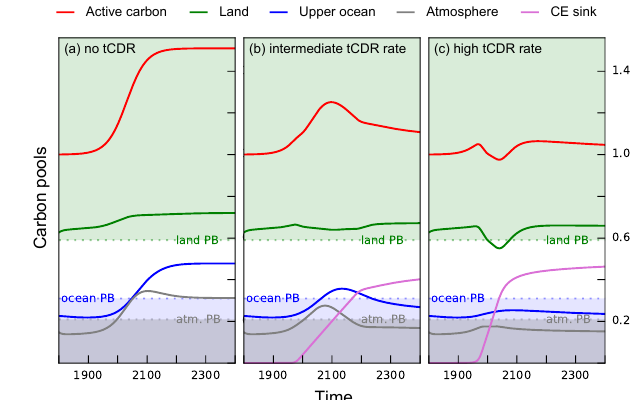
Figure 5. Time evolution of the normalised carbon pools in our model of the carbon system for three tCDR configurations with a high-emission baseline (cumulative emissions as in RCP8.5; Riahi et al., 2011) (a) without tCDR ( α max = 0), (b) intermediate tCDR rate ( α max = 0 . 0025) and (c) high tCDR rate ( α max = 0 . 025). To- tal active carbon (red) is increased by fossil fuel emissions ( c max = 0 . 51) with dynamic response of the terrestrial carbon pool (green), maritime carbon pool (blue) and atmospheric carbon pool (grey). The tCDR sink (purple) stores carbon extracted from the active system. Shaded areas represent the respective safe regions of land, ocean and atmosphere in green, blue and grey. Dotted lines indicate the location of the associated planetary boundaries